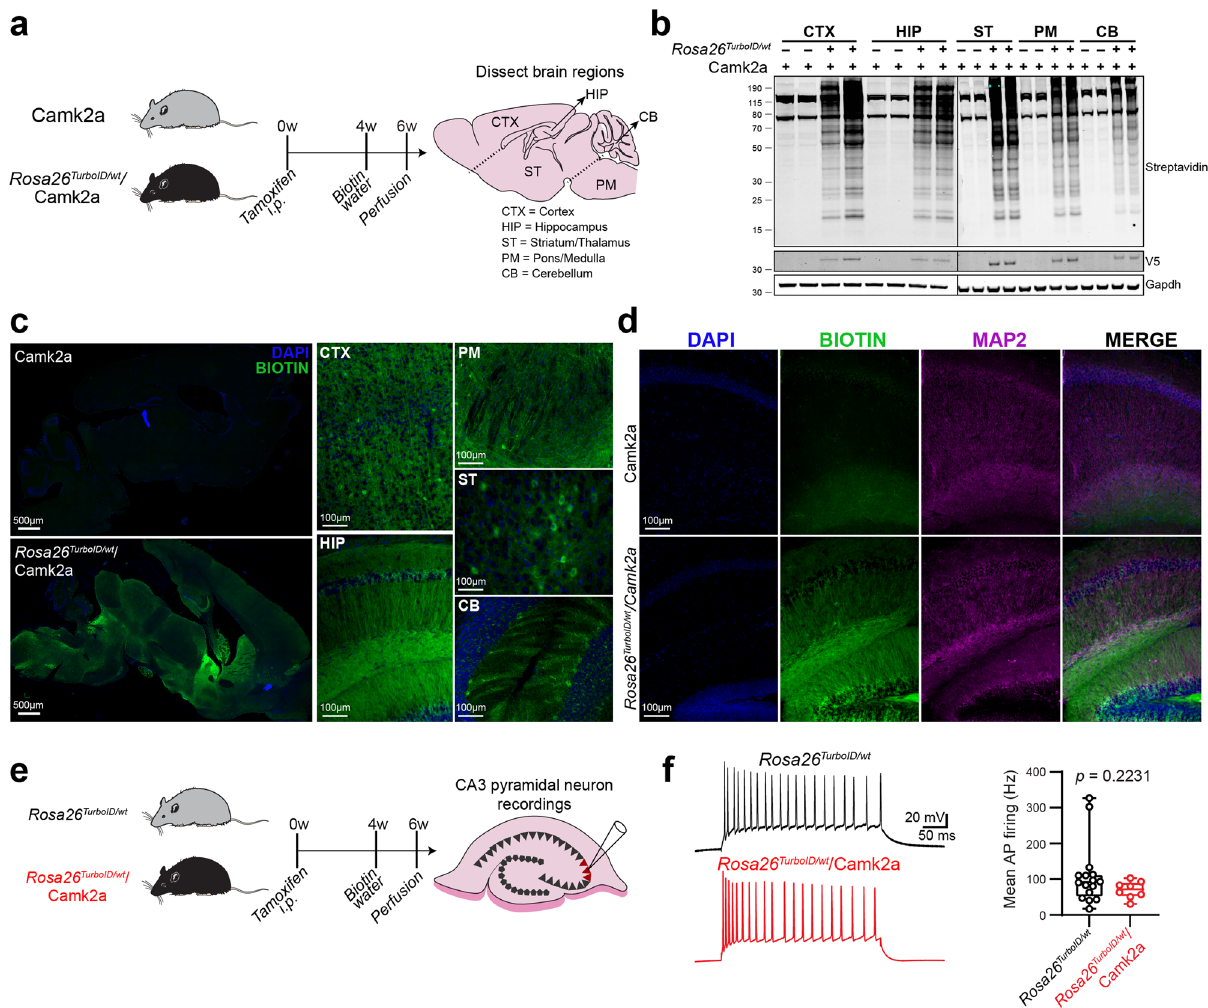
Fig. 2 Successful biotin labeling of Camk2a neurons in adult mouse brain. a Schematic displaying the study design for Camk2a neuron-speci fi c proteomic biotinylation. Heterozygous Camk2a-Cre Ert2 ( n = 2) and Rosa26 TurboID/wt /Camk2a-Cre Ert2 mice ( n = 2) received tamoxifen intraperitoneally (i.p.) once a day for 5 days. After waiting 4 weeks for suf fi cient recombination and washout of tamoxifen effect, mice were supplemented with biotin water (37.5mg/L) for 2 weeks. Brain was dissected into the following regions: cortex (CTX), hippocampus (HIP), striatal region which included the thalamus (ST), brain stem comprised on pons/medulla (PM), and cerebellum (CB). b Representative Western blots from brain lysates ( n = 2 mice/experimental group), probed for biotin (streptavidin fl uorophore), V5 (to detect V5-TurboID-NES), and Gapdh are shown. Rosa26 TurboID/wt /Camk2a brain regions showed biotinylated proteins of different molecular weights as compared to few endogenously biotinylated proteins in the control brain regions. c Representative immuno fl uorescence images ( n = 2 mice/experimental group) showing biotinylation (green: streptavidin Alexa488) across different brain regions. Tiled images of the entire hemisphere (sagittal section) from control and labeled mice, and higher-magni fi cation images from individual regions of labeled mice are shown. Nuclei were labeled with DAPI (blue). d Representative immuno fl uorescence images ( n = 2 mice/experimental group) showing overlap between biotinylation (streptavidin Alexa488) and Map2 expression in neurons and axons in the hippocampus from control and labeled mice. e Experimental outline for hippocampal slice electrophysiology from non-labeled Rosa26 TurboID/wt and labeled Rosa26 TurboID/wt /Camk2a mice ( n = 2 mice/ group). f Electrophysiological recordings from CA3c pyramidal neurons of the hippocampus showing similar fi ring pattern in controls and labeled Rosa26 TurboID/wt /Camk2a mice. Each data point represents a single neuron. Pooled analysis from n = 17 non-labeled control and n = 8 labeled neurons is shown on the right ( p value represents unpaired t -test, p = 0.2231). Data are represented as box plots, indicating median, inter-quartile range, 10th